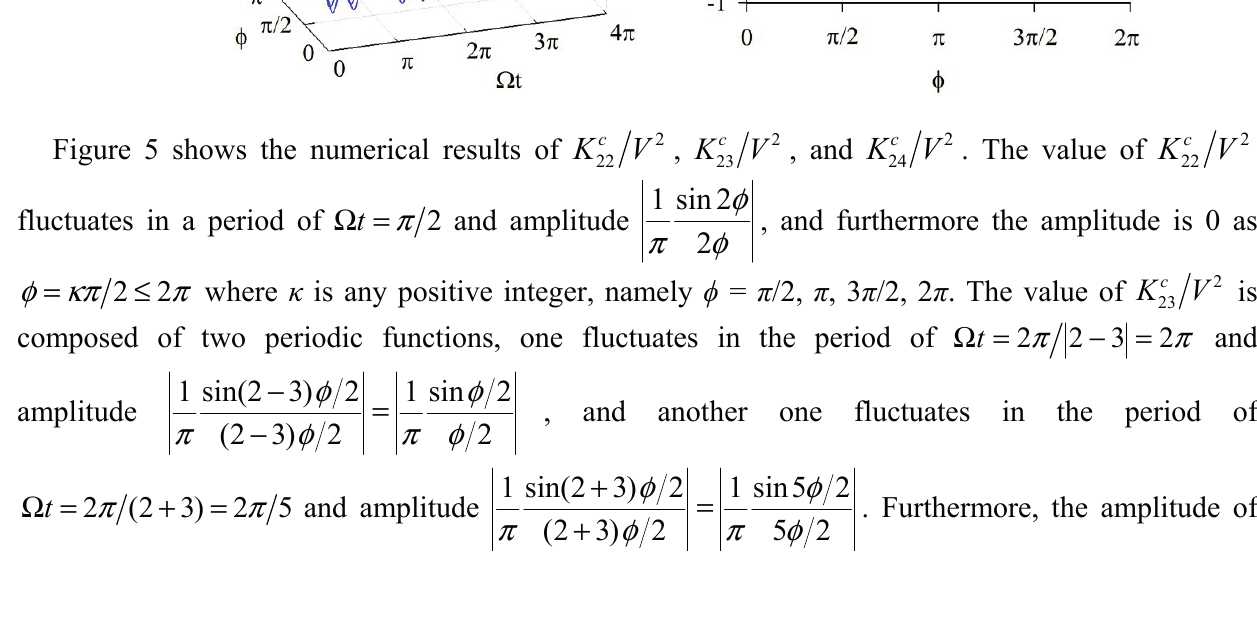
VK c , 2 VK c ) VK c , and 2 22 24 23